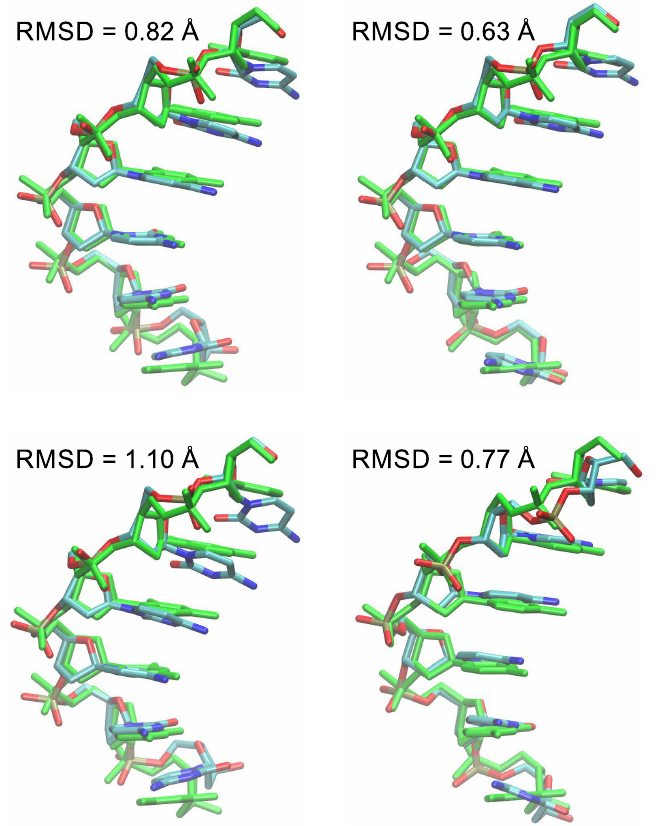
Figure 5. Equilibrium geometry of the ss-C 6 single strand superimposed to the initial B-DNA geometry (green). ( Top left ) B3LYP-D3/6-31G(d,p); ( top right ) B3LYP-D3/TZVP; ( bottom left ) M06- 2X/6-31G(d,p); and ( bottom right ) M06-2X/TZVP. The RMSD (Å) between superimposed structures is also